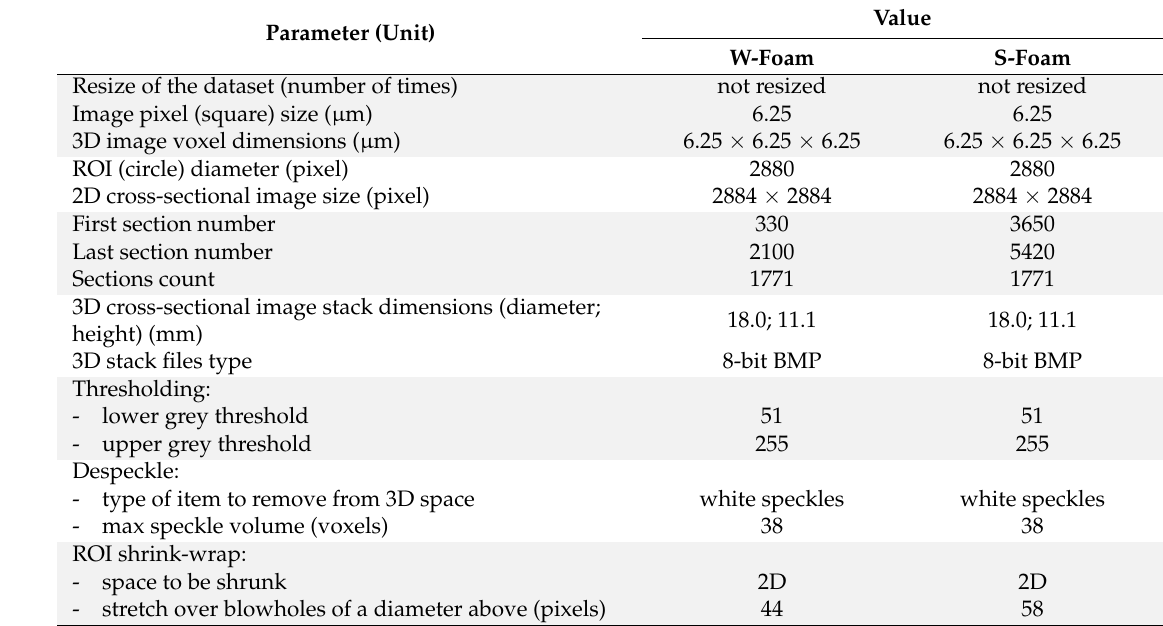
Table 7. The CTAn settings applied in the 3D image analysis.